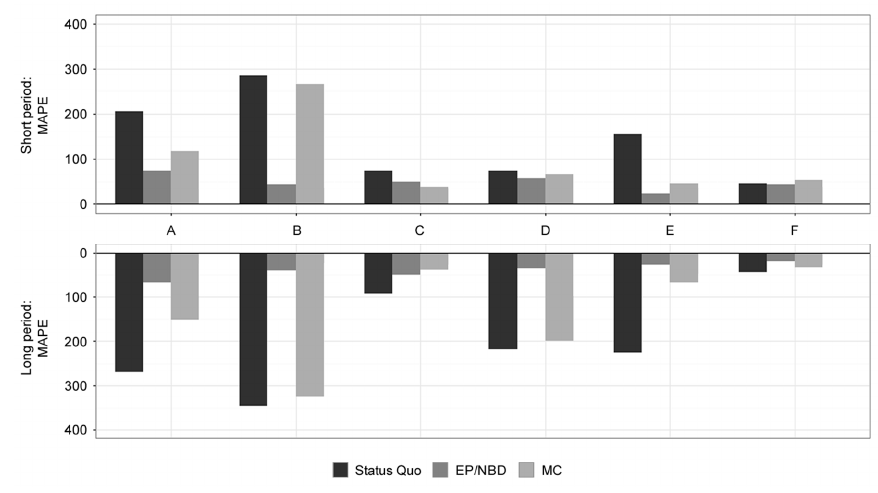
Figure A1. Results for Forecast vs. Actual (in %) for online stores A–F. Source: Authors.